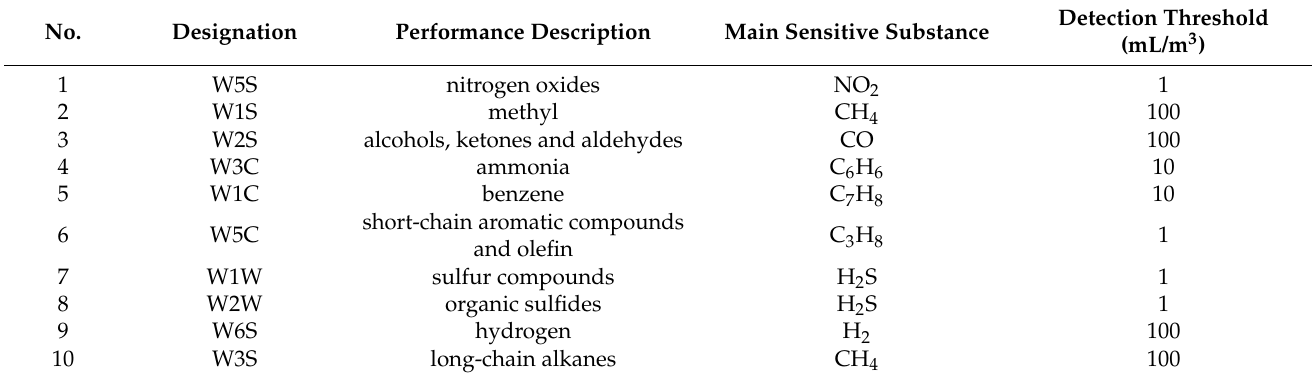
Table 1. E-nose sensor description [23].